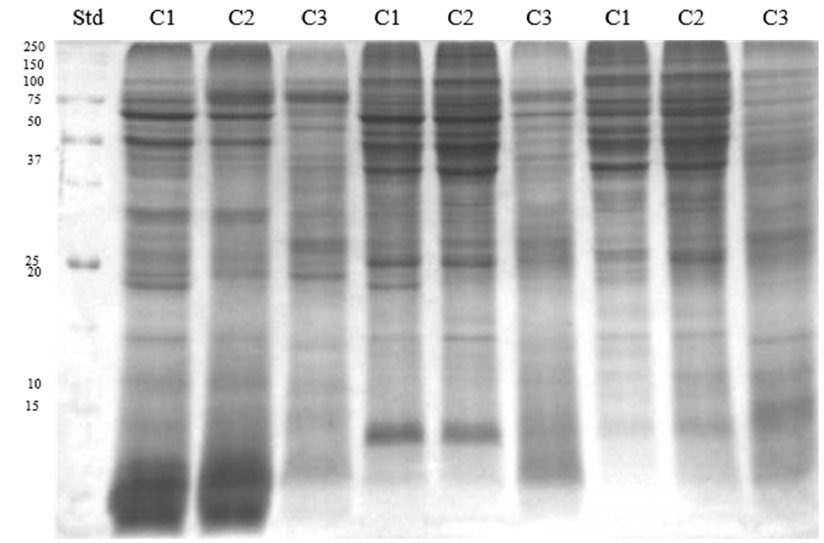
Figure 3. SDS ‐ PAGE profile of sperm proteins obtained during out of the breeding season. C1— Figure 3. SDS-PAGE profile of sperm proteins obtained during out of the breeding season. C1—caput, caput, C2—corpus, C3—cauda. Std.—molecular weight standards. C2—corpus, C3—cauda. Std.—molecular weight